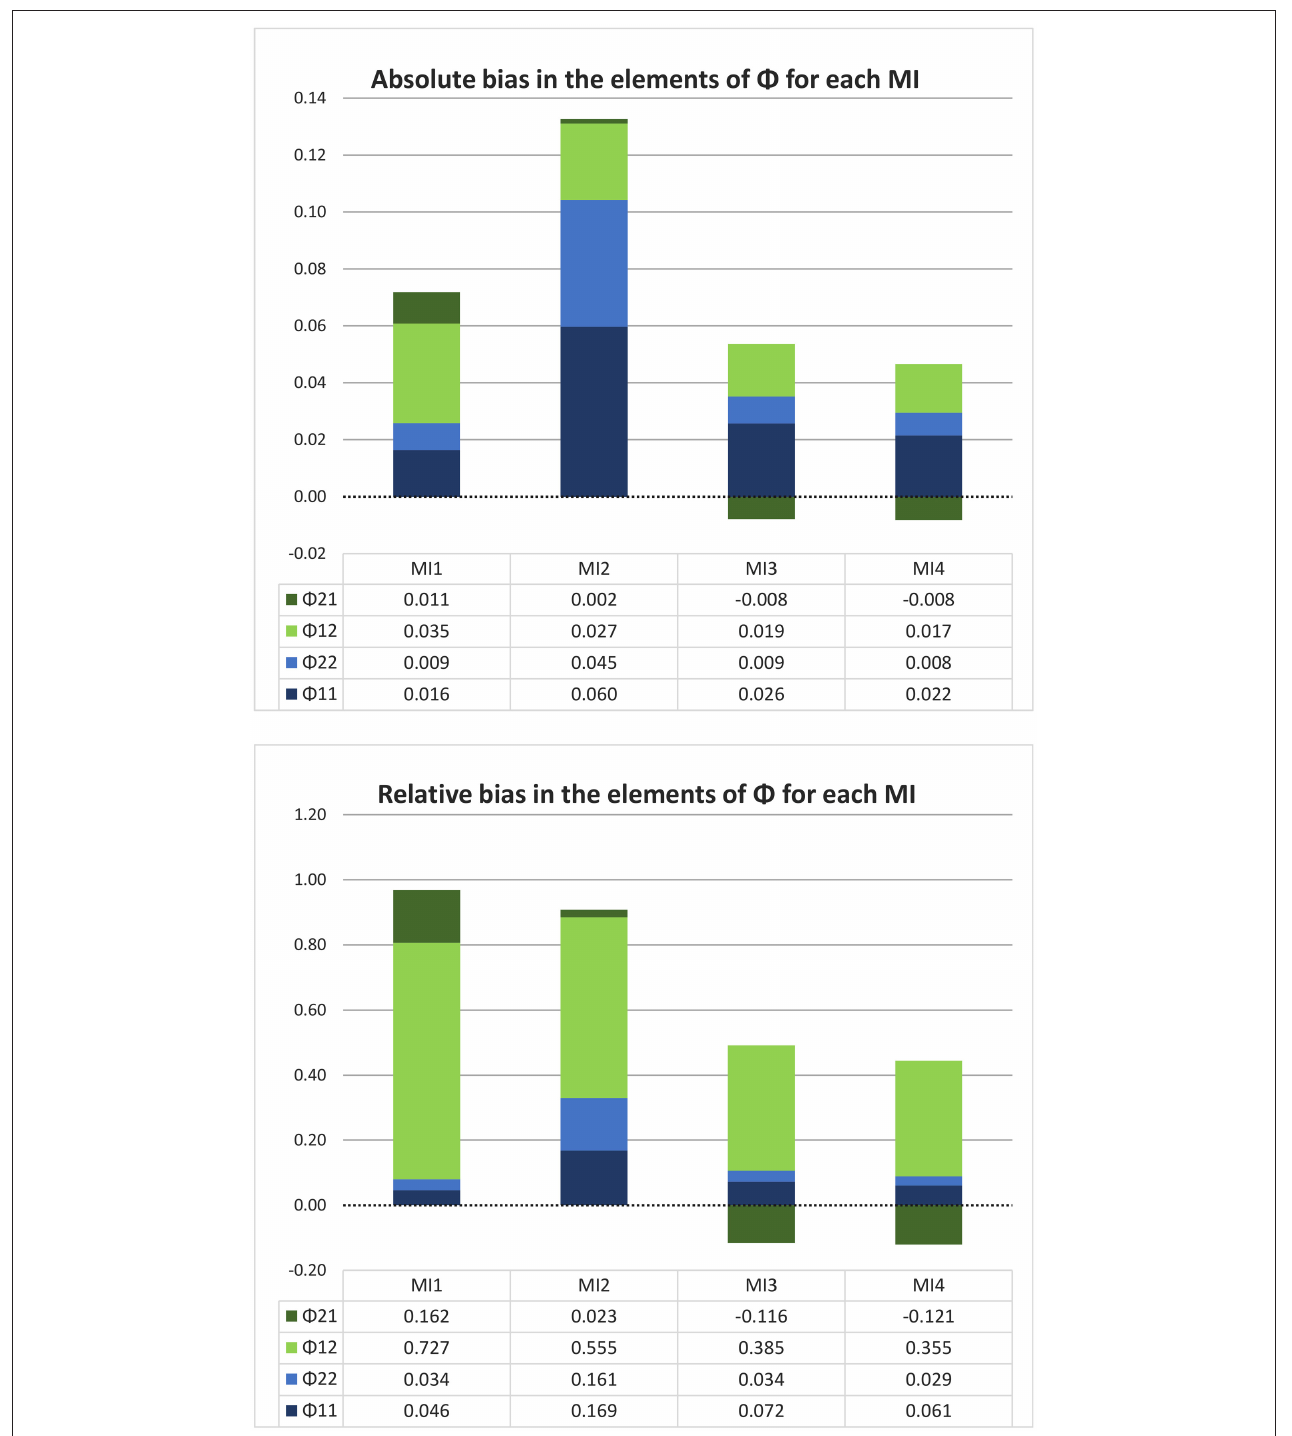
FIGURE 6 | Absolute and relative bias in 8 for each model implementation in the bivariate simulation with one very long time series (1,000 days) and no minimum interval length. In this graph, each stacked bar represents a model implementation and each color represents a different element of the matrix 8 , with the autocorrelations in blue and the cross-coefficients in green. It can be seen that MI 1 and 2 have a greater total amount of bias (longer bars) than MI 3 and 4, and that only the latter two model implementations have any negative bias (namely, for φ 21 ). MI 2 stands out particularly because of its large positive bias in both of the